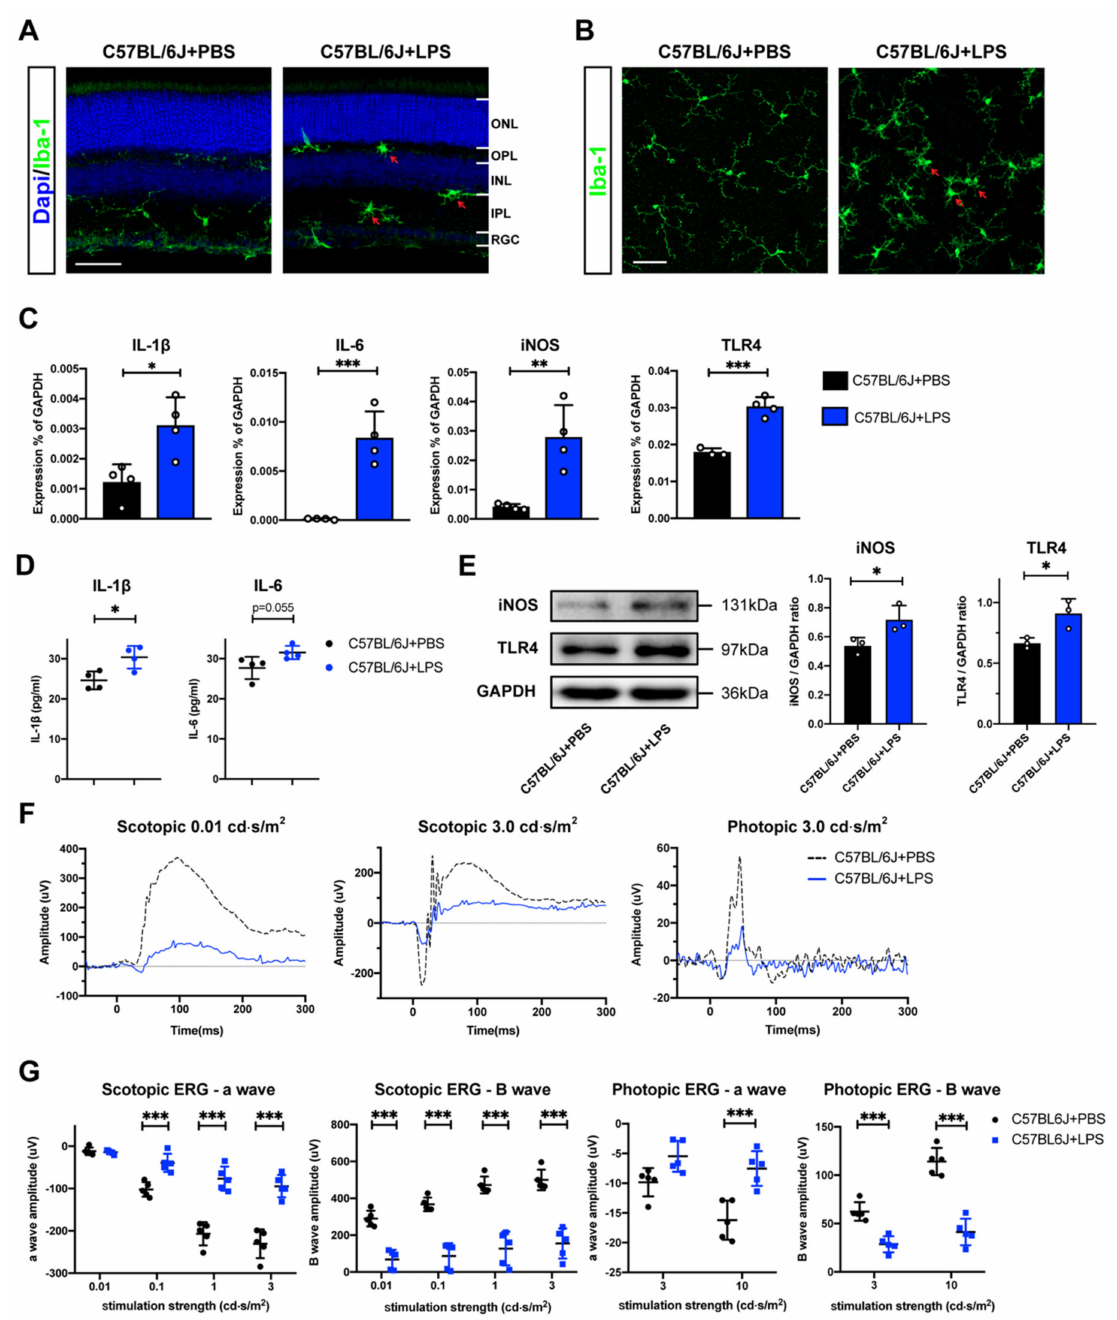
Figure 1. Retinal evaluation of the endotoxin-induced uveitis (EIU) model. Confocal images of retinal sections ( A ) and retina whole-mount focusing on the inner plexiform layer (IPL) ( B ) from C57BL/6J mice 24 h after receiving an intraperitoneal injection of LPS (5 mg/kg) or PBS (blue: Dapi; green: Iba-1; red arrows: activated microglial cells; scale bars, 50 µ m). ( C ) Expression levels of mRNA for interleukin 1 β (IL-1 β ), interleukin 6 (IL-6), inducible nitric oxide synthase (iNOS), and toll-like receptor 4 (TLR4) in the retina tissue from PBS and LPS groups (n = 4), ( D ) ELISA analysis of IL-1 β